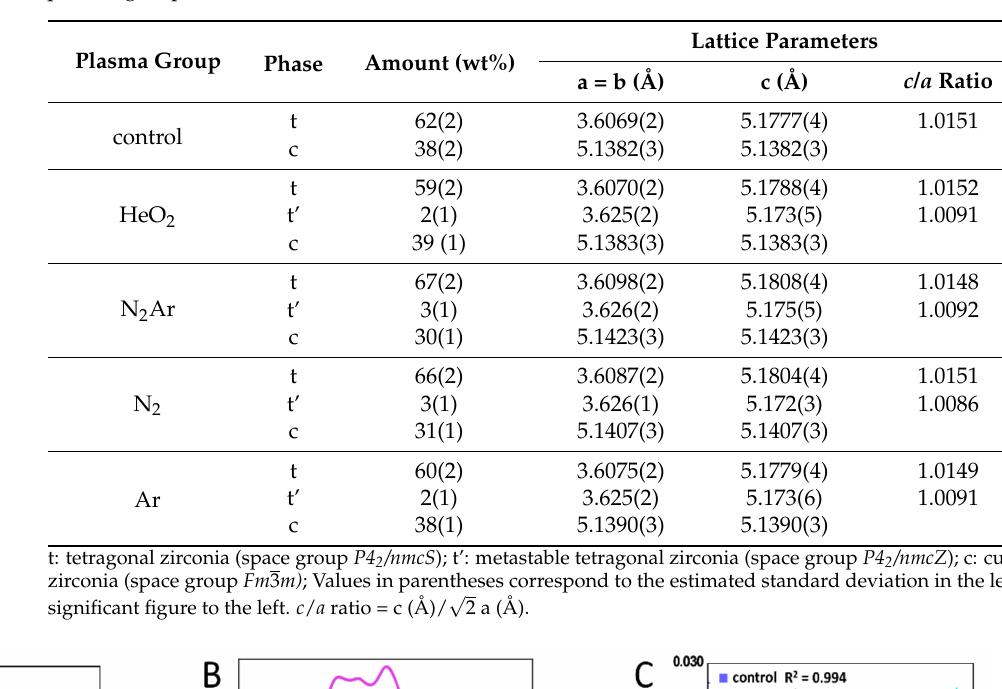
Table 2. Rietveld analysis results for the phase compositions and the lattice parameters in each plasma group.